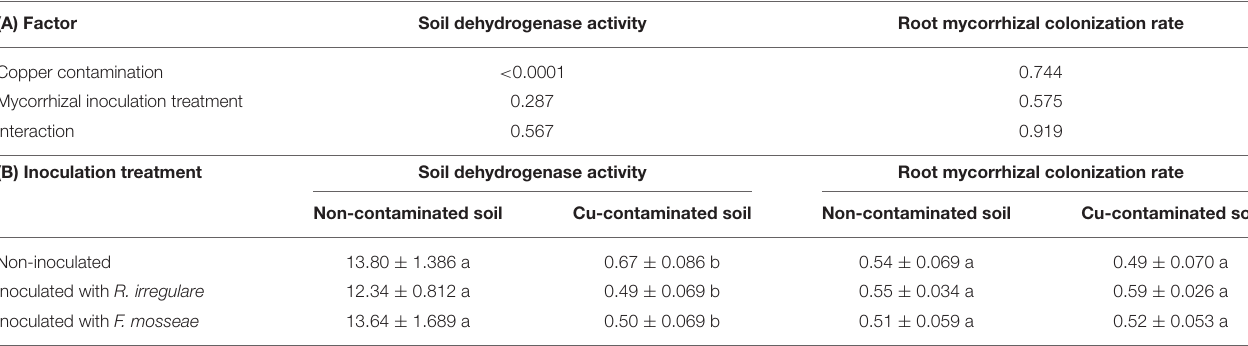
TABLE 3 | (A) P -values of the two-way ANOVA for the effects of the factors “Copper contamination” and “Mycorrhizal inoculation treatment” and their interaction; (B) Soil dehydrogenase activity (in mg TPF g − 1 dry weight) and root mycorrhizal colonization rate in Touriga Nacional plants grafted onto 1103 Paulsen rootstock at the end of the growing